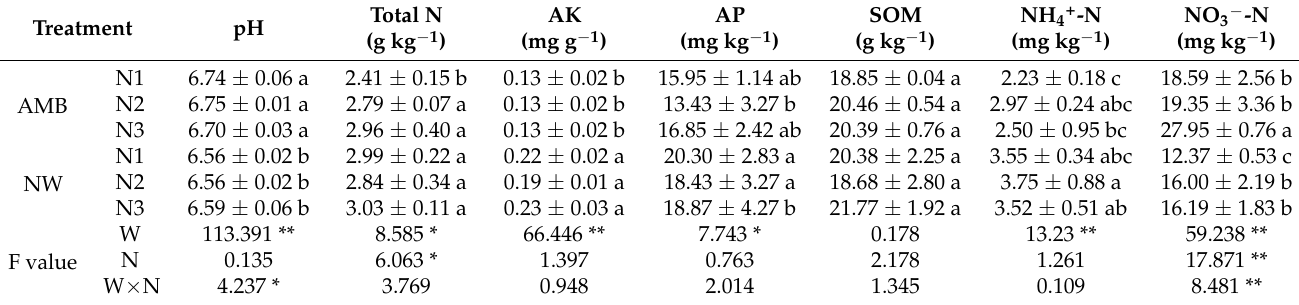
Table 1. Effects of nighttime warming and nitrogen application on soil physical and chemical